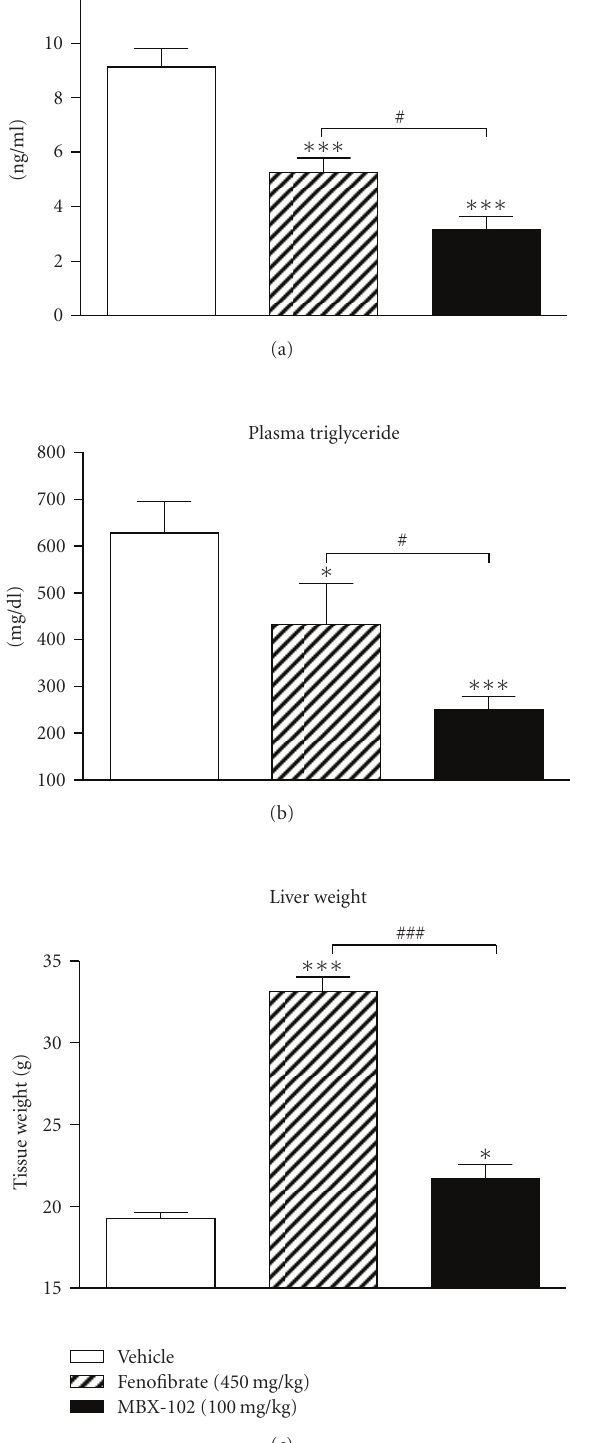
Figure 5: E ff ect of MBX-102 (100mg/kg) and fenofibrate (450mg/kg) on fasting plasma insulin (a), triglycerides (b), and liver weights (c) after 32 days of treatment of male ZF rats. Values are plotted as mean ± SEM ( ∗ : P < . 05, ∗∗∗ : P < . 001 versus ZF vehicle, #: P < . 05, ###: P < . 001, MBX-102 versus fenofibrate, 1-way ANOVA, and Newman-Keuls multiple comparison test).